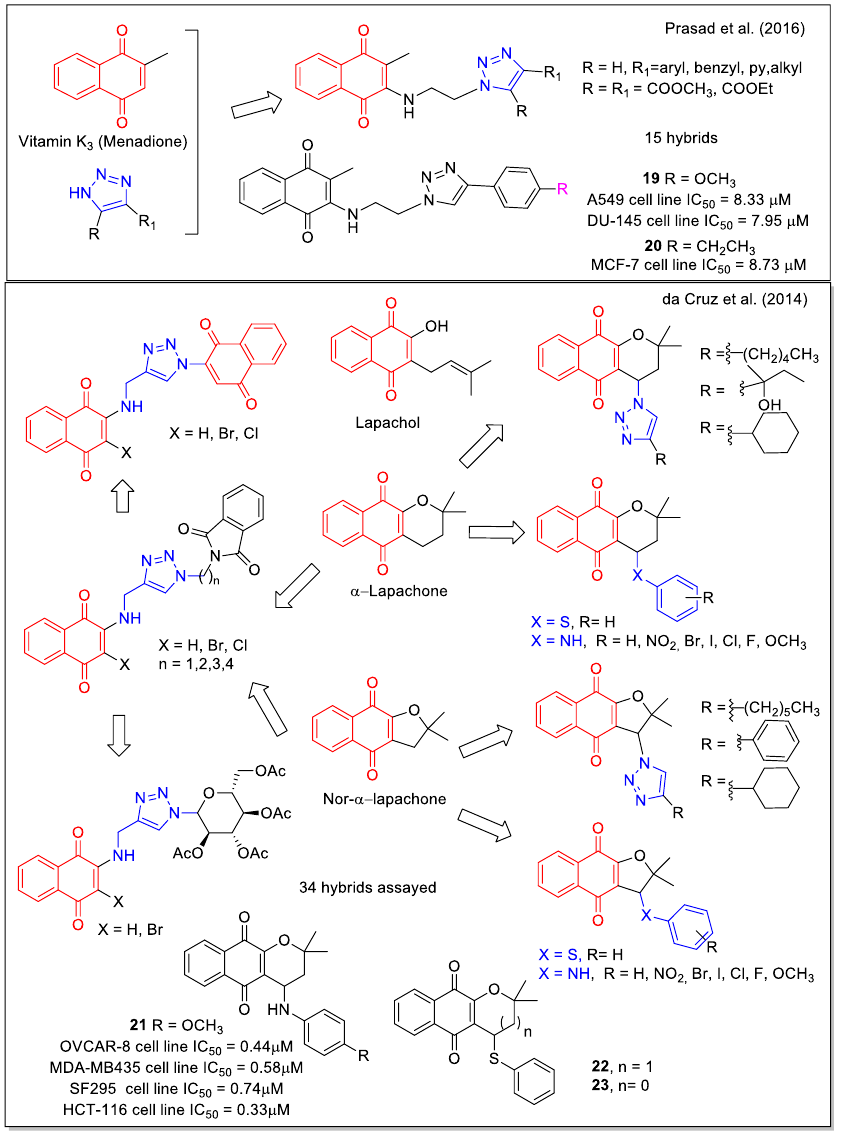
Figure 7. 1,4-Naphthoquinone hybrids as reported by Prasad et al. [35] and by da Cruz et al. [36]. Relying on the relevant bioactivities of C-aryl glycosides and on their favorable sta- bility when compared with O- glycosides, which are instead labile to enzymatic and chemical hydrolysis, Chakraborty et al. [38] considered structures containing an NQ agly- cone. In particular, the pyranonaphthoquinone structure, present in the Streptomyces metabolites griseusin B and mederrhodin A (Figure 8), is responsible for the reductive bioalkylating action, relevant in the mechanism of action against cancer cells. A series of NQ/naphthoquinol–carbohydrate hybrids, obtained in high yield by a regioselective route, were tested against the human cervical cancer cell line, with compound 24 being the most